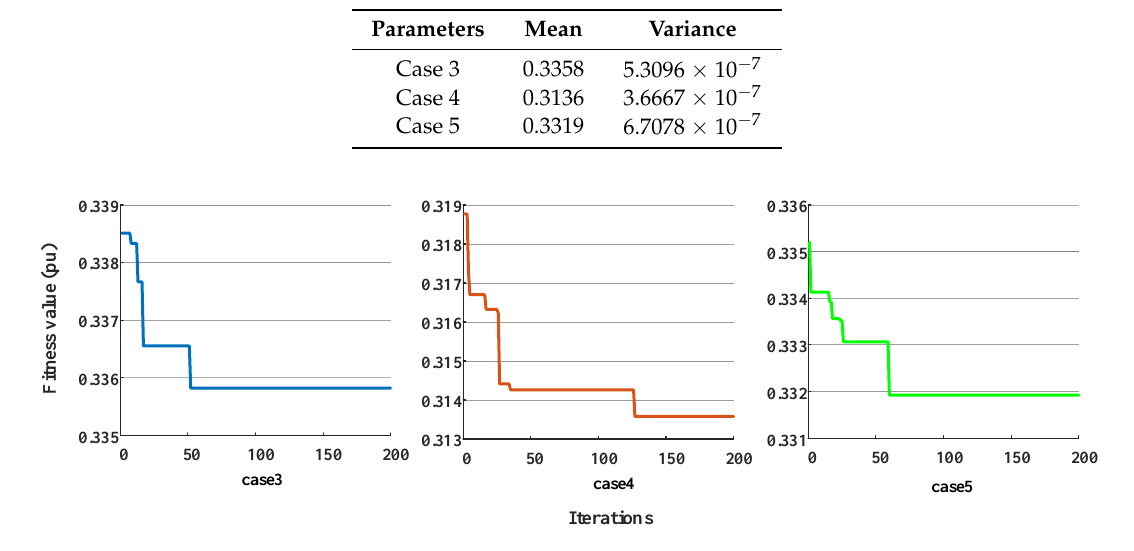
Figure 6. Fitness function convergent curve.